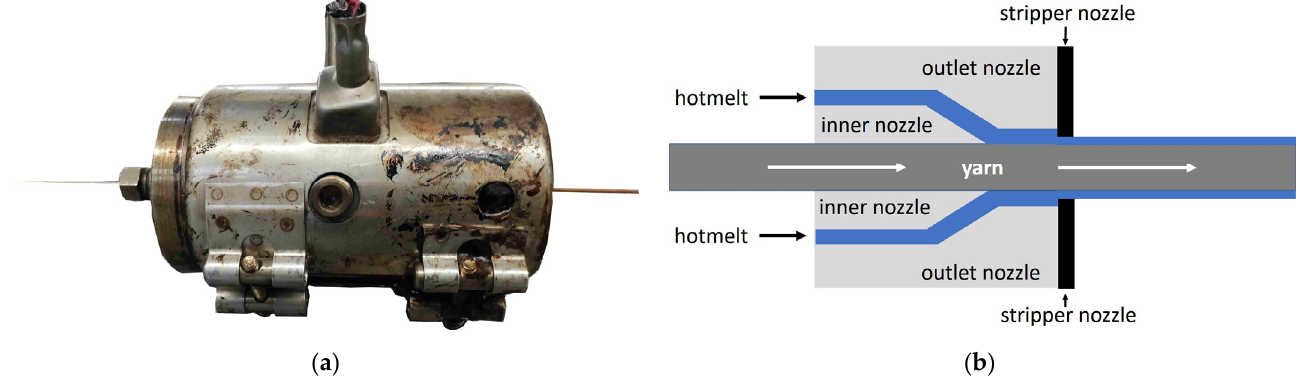
Figure 1. ( a ) Picture of the sheathing nozzle; ( b ) functional sketch of the sheathing nozzle.